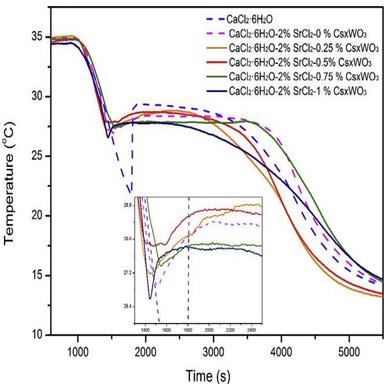
Cooling curves of CaCl2·6H2O with different mass ratio of CsxWO3 nanoparticles.